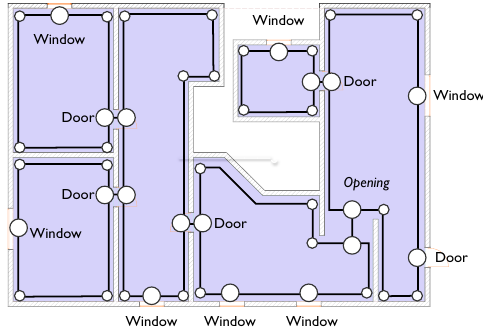
Figure 8: Specialised route graph based on the positioning of features along walls of room in a building.